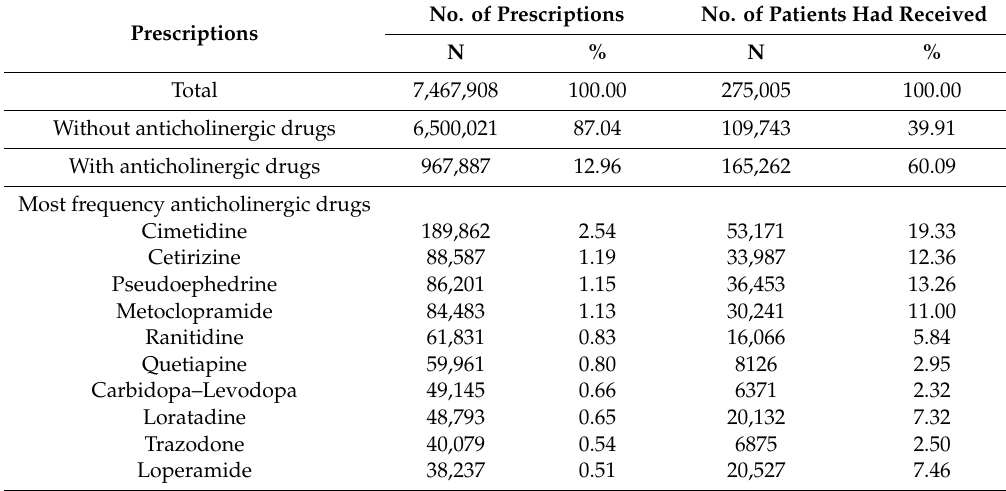
Table 1. The distribution of prescriptions in elderly